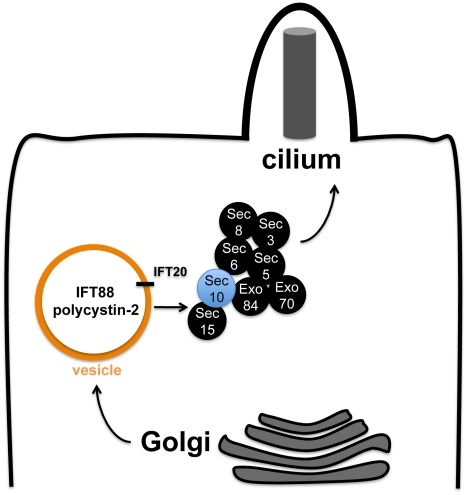
Model for the role of the exocyst in trafficking ciliary
proteins.Our model for the trafficking of essential proteins to the primary cilium
posits that the exocyst is first localized to the primary cilium, and then
targets and docks secretory vesicles from the trans-Golgi network carrying
ciliary proteins such as polycystin-2 and IFT88—which are marked by
the presence of IFT20.